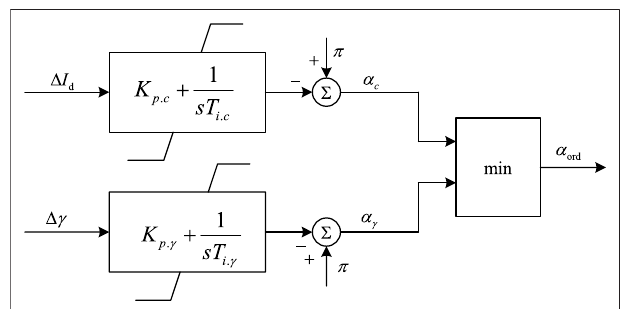
FIGURE 6 | Δ I d is the difference between the setting value of the DC current and the actual value on the inverter side; Δ c is the difference between the setting value of the extinction angle and the actual value. For the recti fi er side, Δ I d isthedifferencebetweenthesettingvalueoftheDCcurrentand the actual value on the recti fi er side. It can be seen that the extinction angle control in this control strategy is a measured control mode, which is a closed- loop